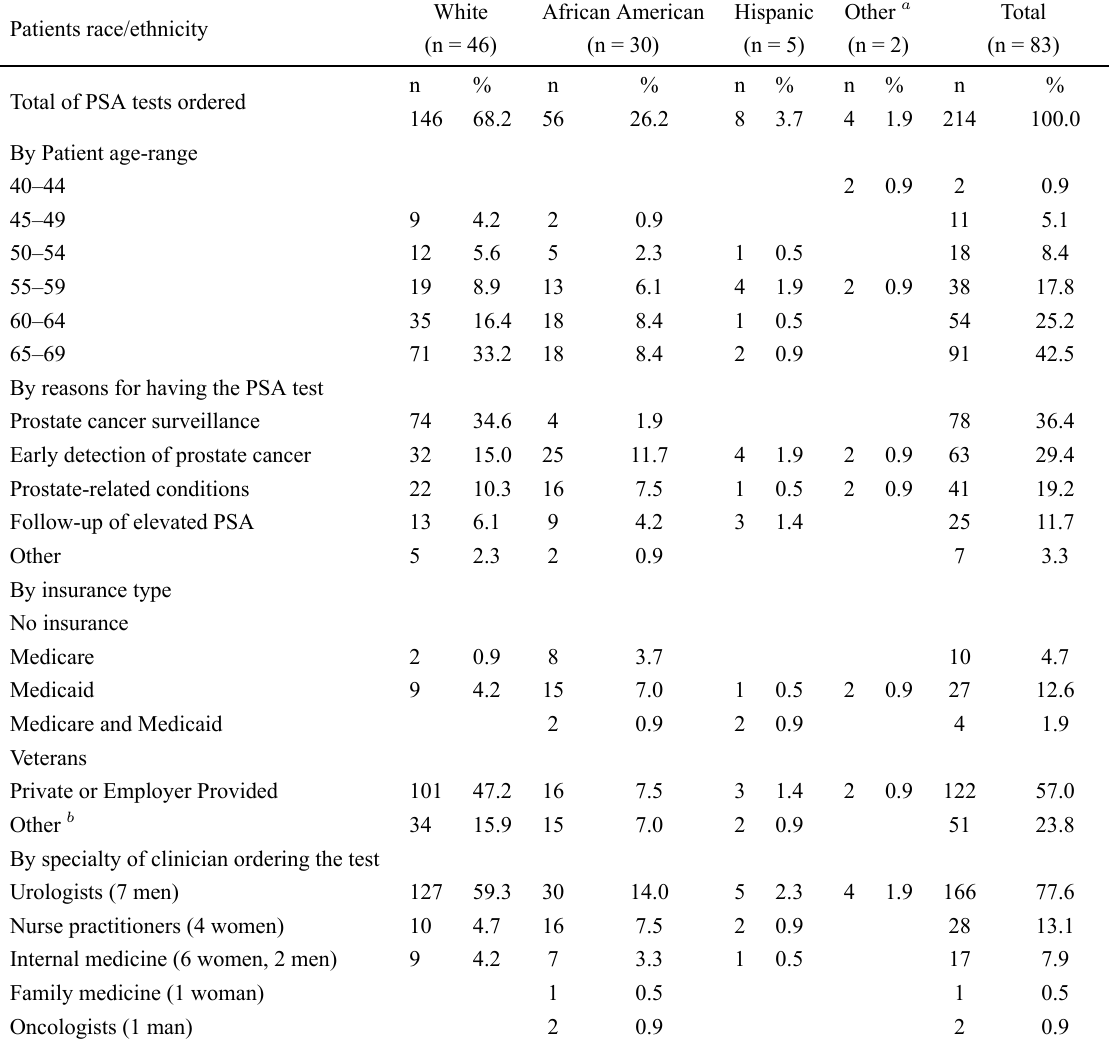
Table 4. Total PSA tests ordered